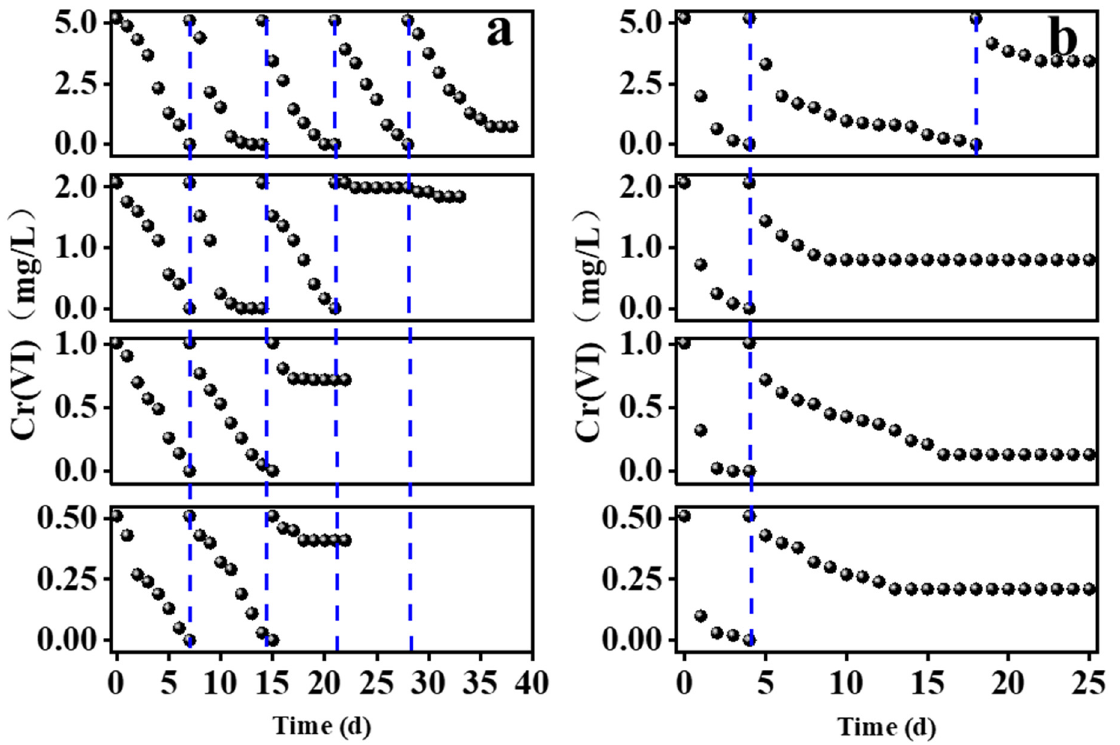
Figure 3. Sequential batch experiments comparing the Cr(VI) removal efficiencies of the different ZVI materials over the initial concentration range 0.5–5.0 mg/L: ( a ) ZVI-ALOX; ( b )